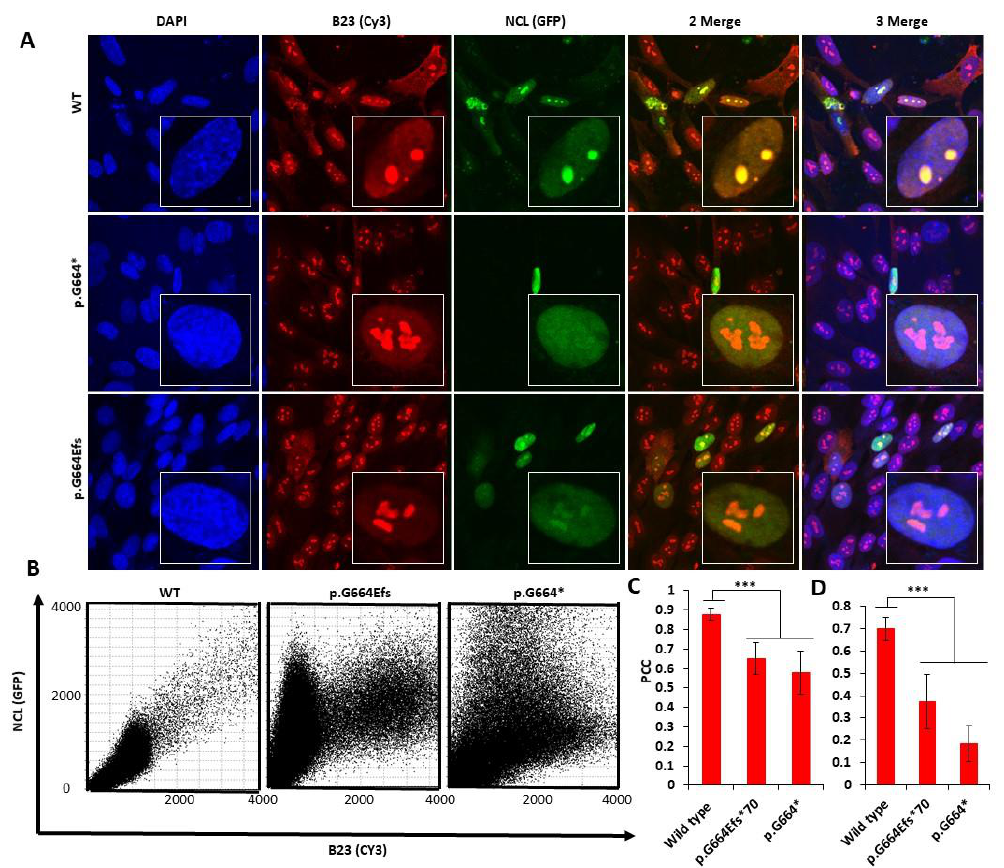
Figure 2. Comparison of the nucleolar localization of wild-type and mutant NCL expressing in HEK293T cells. ( A ) Confocal image stacks representing (left to right): column 1 DAPI (Blue), column 2 B23 (Red — CY3), column 3 NCL (green — GFP), column 4 merge B23-NCL CY3 (red) and GFP (green), column 5 All merge DAPI-GFP-Red (DNA-NCL-B23). Row 1 (left to right) wild-type, Row 2 (left to right) p.G664*, and Row 3 (left to right) p.G664Efs*70. Note that all images shown here are representative of the authors’ observations; averaged data from all images are presented in the quantitative analysis and discussed in the main text. ( B ) Scatter plot of red and green pixel intensities showing co-localization of B23 (Red—Nucleolus) and recombinant NCL protein (GFP). ( C ) Pearson’s correlation coefficient (PCC) values of B23 (Red—Nucleolus) and recombinant NCL protein (GFP) were plotted to represent quantitative co-localization of NCL in nucleus and ( D ) Nucleolus (n WT = 14, n p.G664 = 16 and n p.G664Efs = 16; p *** values ≤ 0.005 one-way ANOVA; ± SD is shown. Additional co-localization images are shown in Supplementary Material Figure